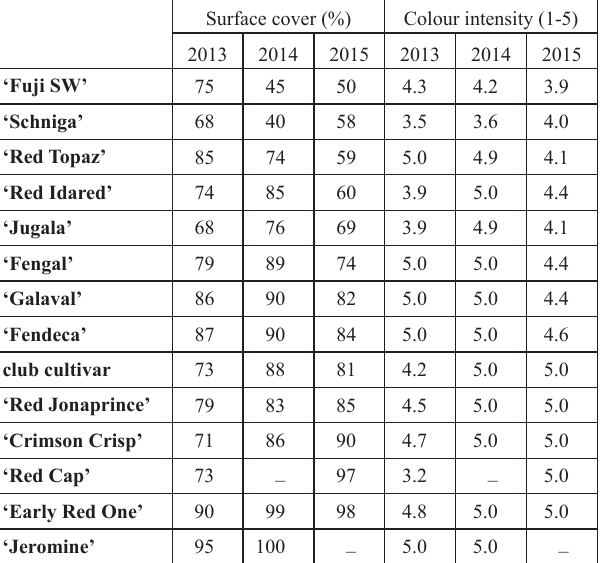
Table 2 : Fruit surface colour and colour intensity of apple cultivars (Nyírbátor, 2013-2015).